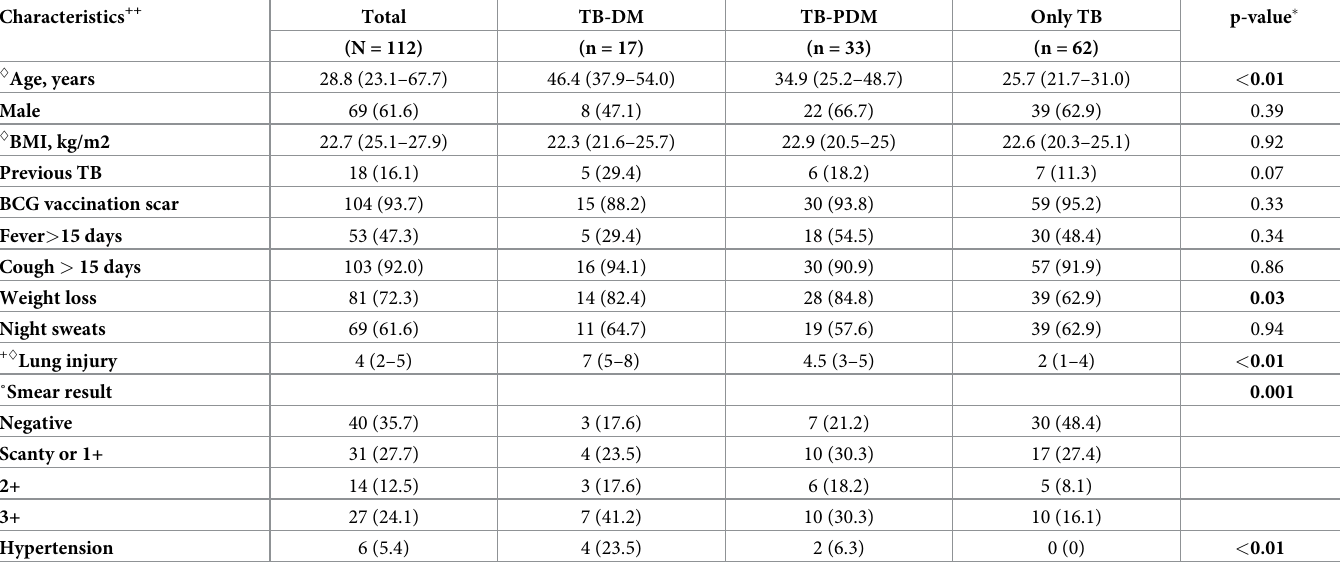
Table 1. Baseline epidemiological and clinical characteristics of the study population. Characteristics ++